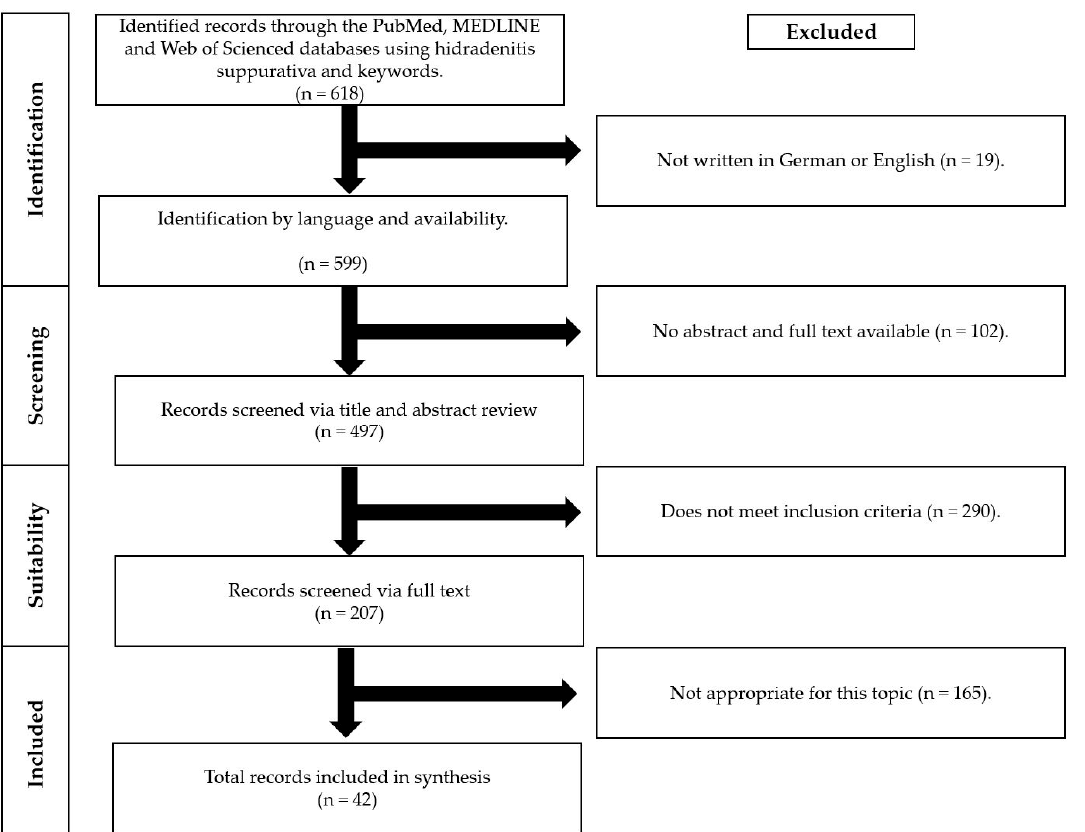
Figure 1. Flowchart with the research strategy in this systematic review.